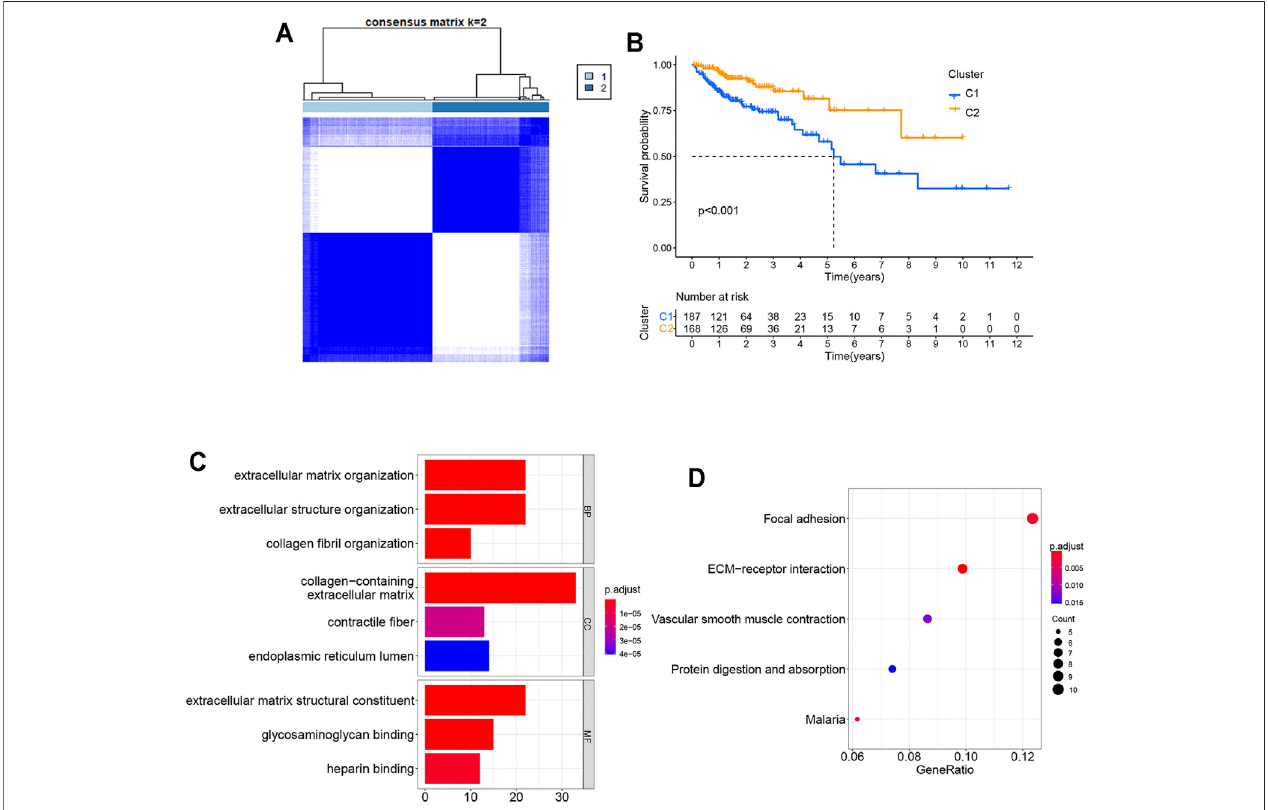
FIGURE3 | Tumor classi fi cation based on thepyroptosis-related DEGs. (A) COAD patients were grouped into twoclustersaccording tothe consensus clustering matrix(k (cid:1) 2). (B) Kaplan – MeierOScurvesforthetwoclusters. (C) GObargraphforgenesinBP,CC,andMF. (D) Bubblegraphoftop5KEGGpathwayswiththemost enriched genes; the vertical axis refers tonames of the pathway; and the horizontal axis refers to the number ofgenes. GO, Gene Ontology; BP, biological process; CC, cellular component; MF, molecular function; KEGG, Kyoto Encyclopedia of Genes and Genomes.